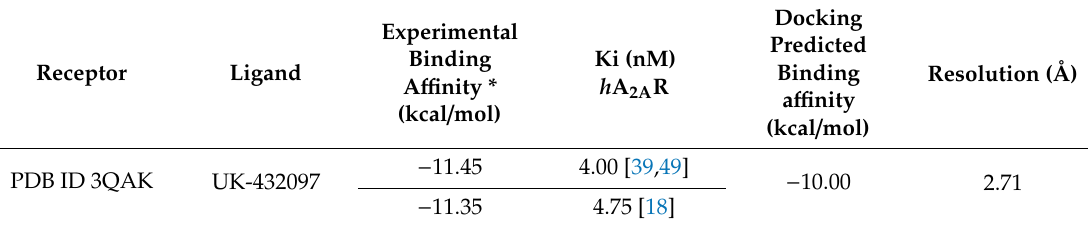
Table 10. Comparison between experimental and theoretical binding a ffi